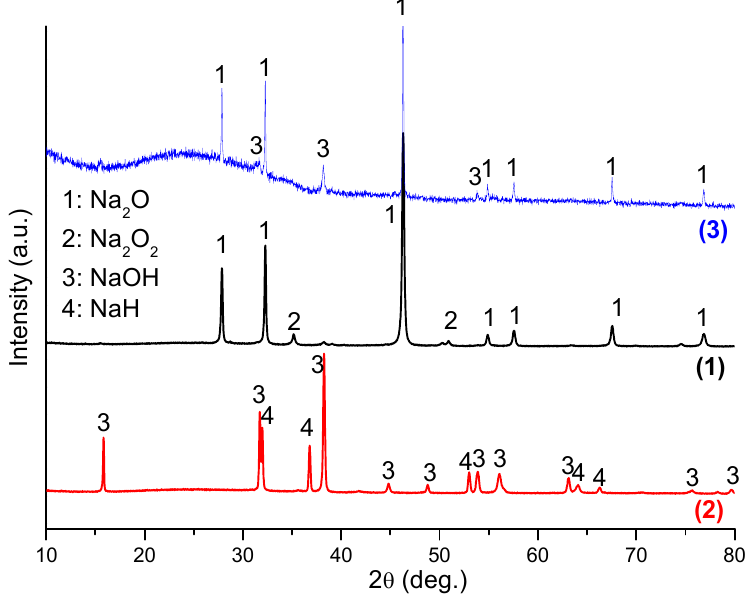
Figure 2. XRD patterns of Na 2 O after ball milling (sample 1), after hydrogenation at 400 °C/18 bar H 2 (sample 2), and after subsequent dehydrogenation at 400 °C (sample